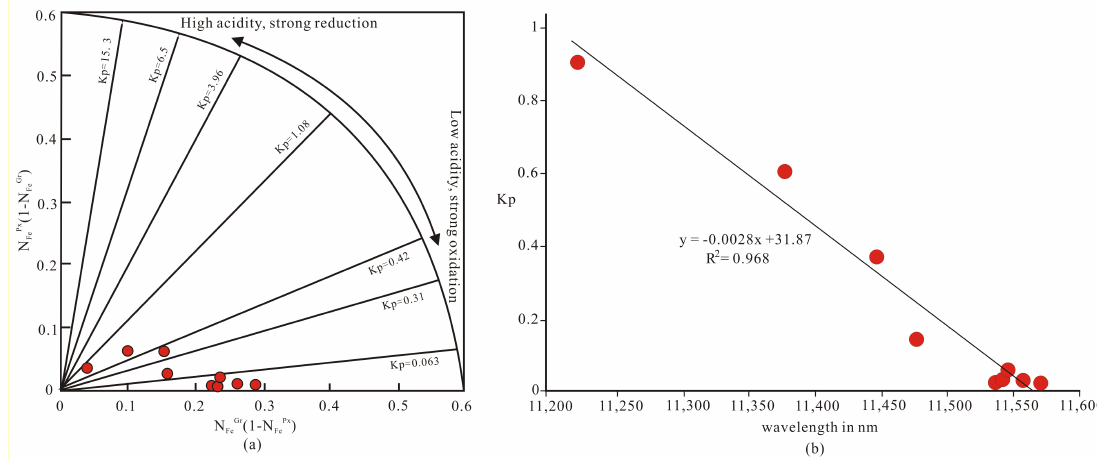
Figure 9. The relationship between garnet wavelength and redox properties. ( a ) Kp calculation diagram (adapted from Zhao et al. [62]), ( b ) Correlation between garnet wavelength and and Kp.